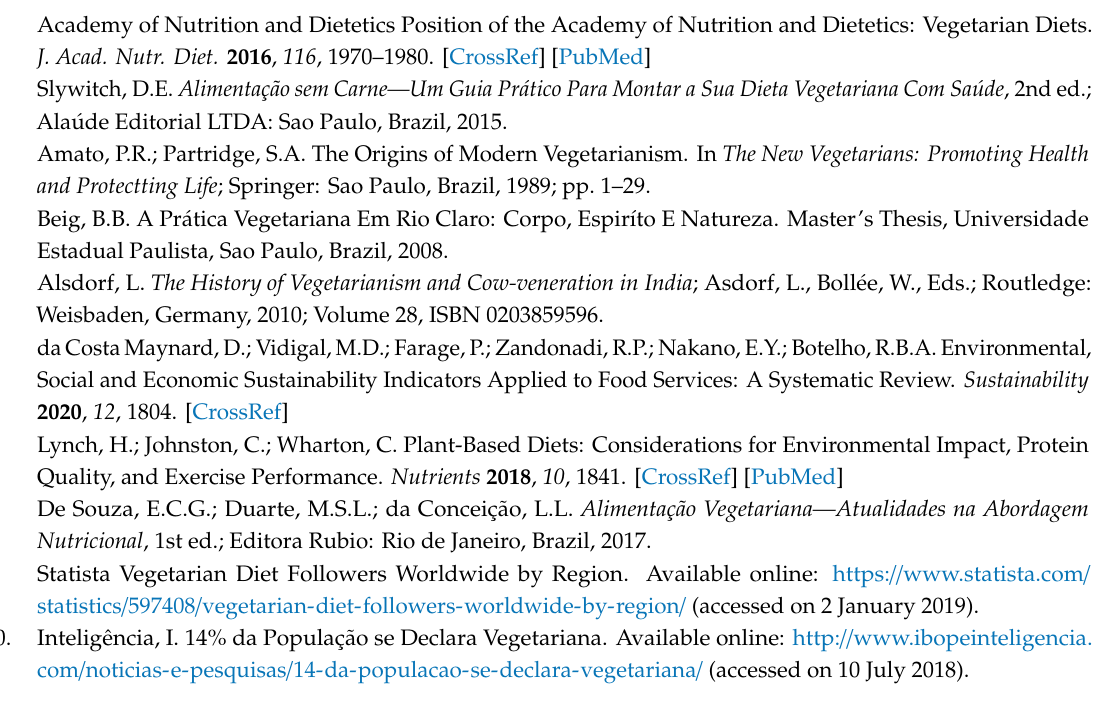
Table S1. Items that compose the Vegetarian Diet Associated Quality of Life questionnaire (VEGQOL): final result of the questionnaire after content and semantic validation by the judges’ technique. Original version in Brazilian-Portuguese; Table S2. Pearson correlation between VegQol and WHOQOL-BREF domains. Author Contributions: Conceptualization, S.M.H. and R.P.Z.; methodology, S.M.H. and R.P.Z.; validation,